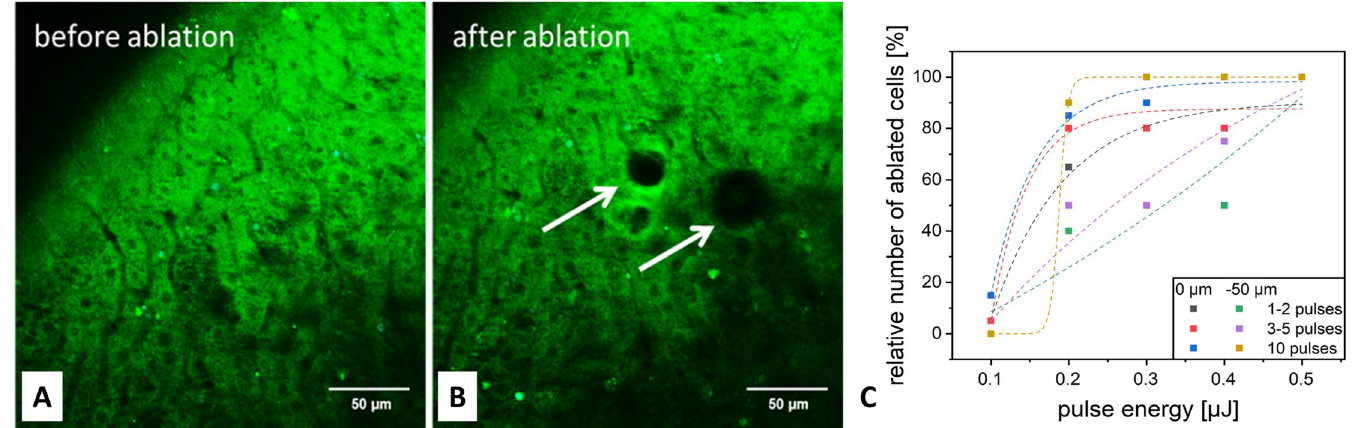
Fig 4. Single cell ablation ex vivo : ( A, B ) Visualisation of cell damage after application of the amplifier laser system. ( C ) Evaluation of the targeting efficiency.